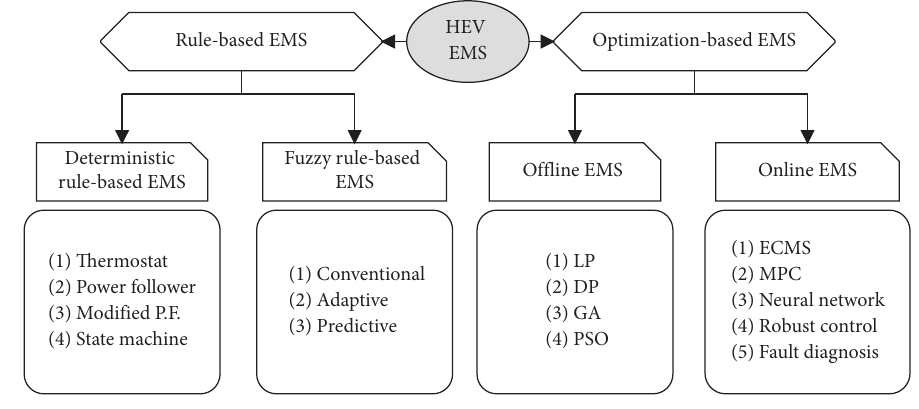
Figure 1: Classification of EMS for